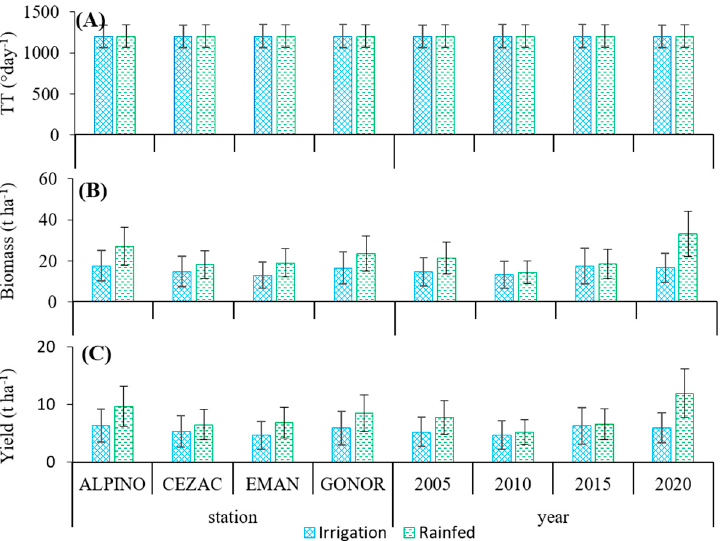
Figure 2. Averages (± standard deviation) of the output variables, thermal time ( A ), biomass ( B ) and yield ( C ) of irrigated and rainfed beans for the SIMPLE model in trials between weather stations and between years in Zacatecas, Mexico.